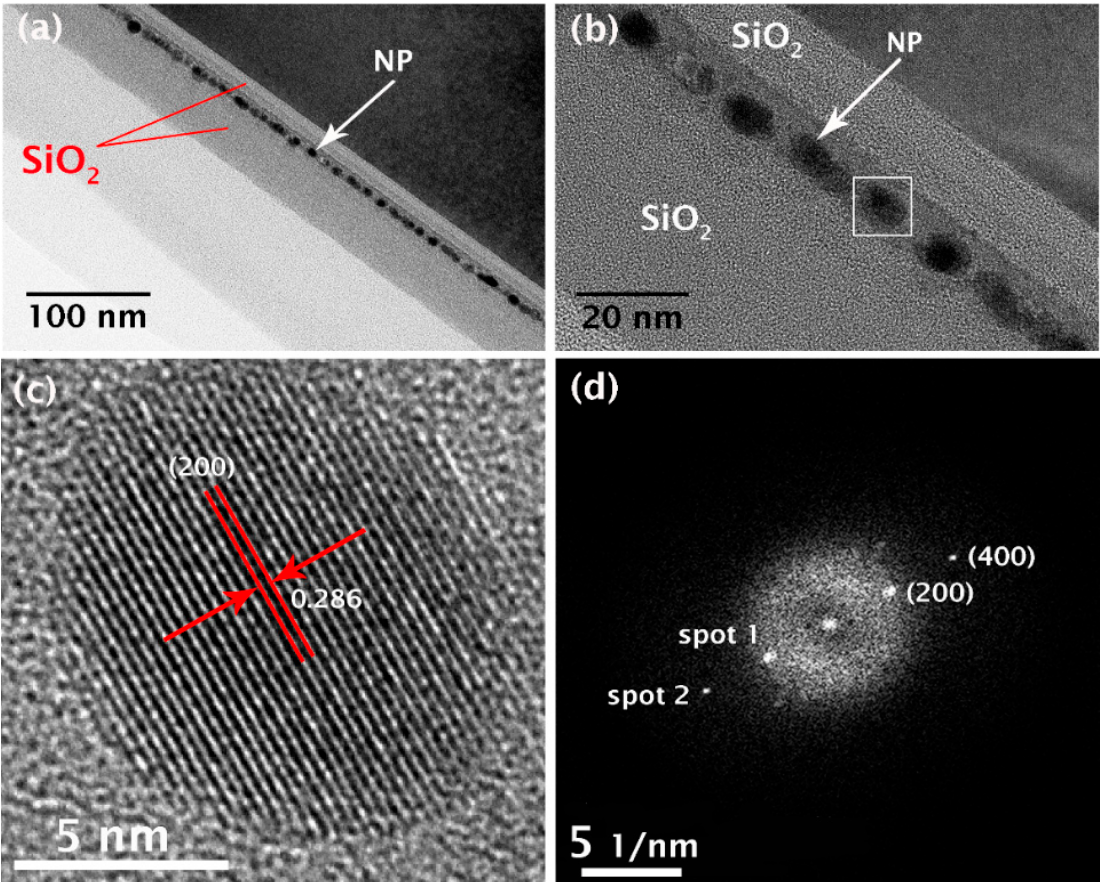
Figure 2. TEM images of the stacked SiO 1.3 /Al/Sn/Al/SiO 1.3 structure sandwiched between two SiO 2 layers after annealing at 500 °C for 30 min. ( a ) Low- and ( b ) high-magnification images; ( c ) high-resolution TEM image of the nanoparticle (NP) indicated by the white square in (b); and ( d ) fast Fourier transform (FFT) pattern associated with the lattice structure in (c).